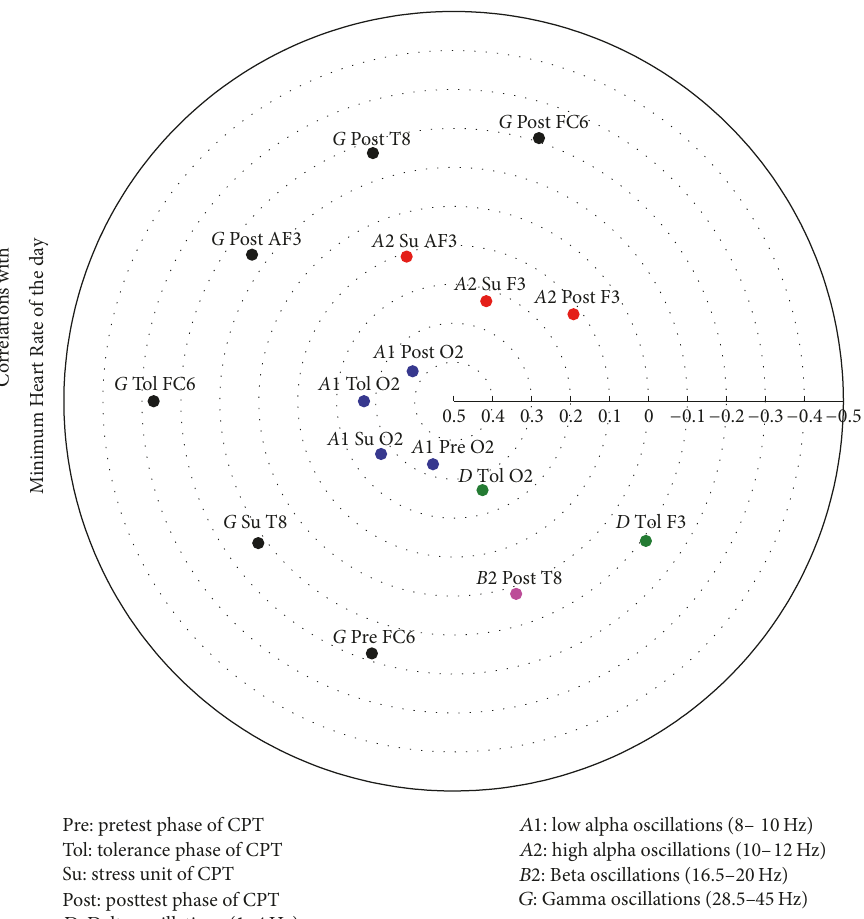
Figure 10: Heliograph of the correlations between Minimum Heart Rate of the day and the statistically significant different CPT-induced EEG oscillations depicted by concentric circles in the ( − 1)-(0)-(+1)